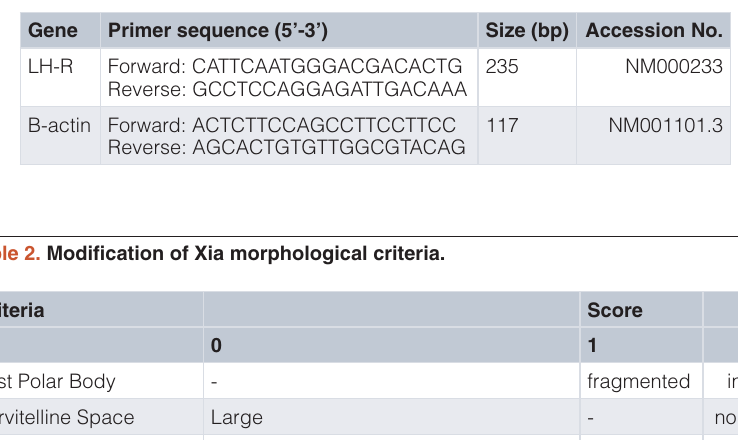
Table 1. Real time polymerase chain reaction primer sequences.